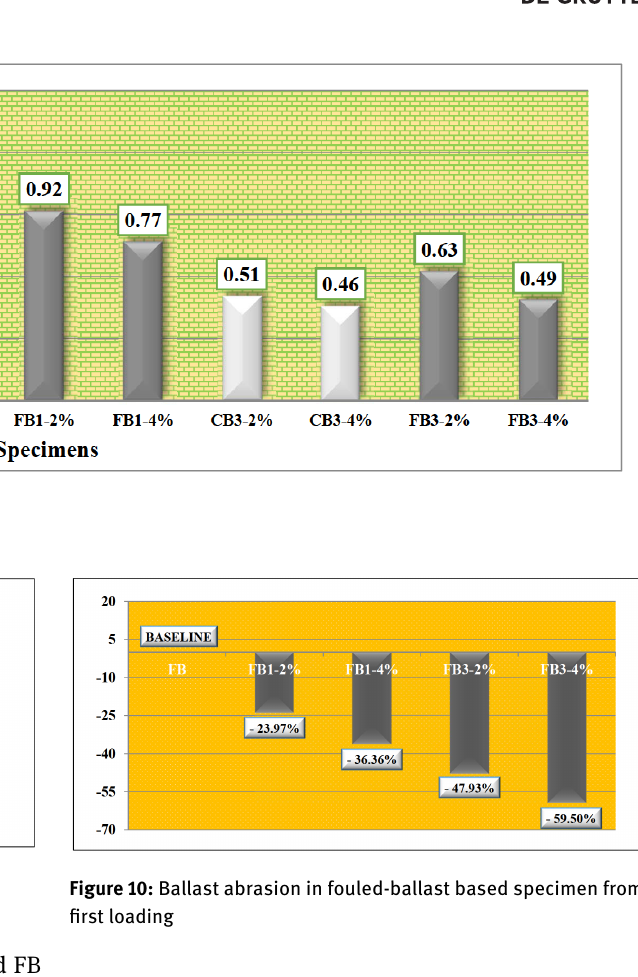
According to Figure 8, specimens CB (0.98%) and FB